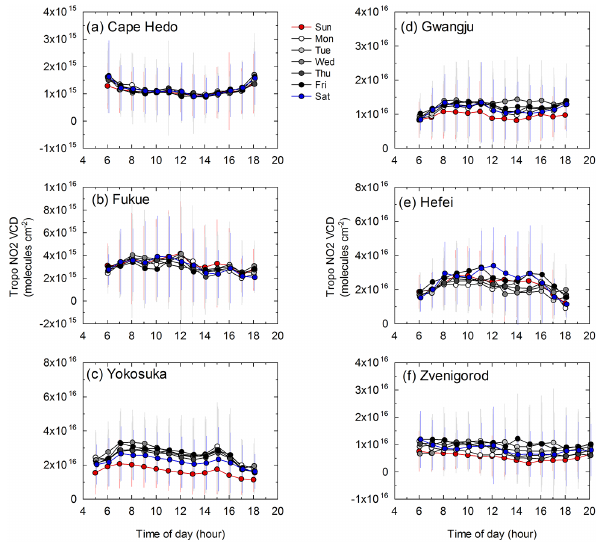
Figure 16. Weekend reduction ratios for TropoNO2VCD derived from MAX-DOAS and OMI (using the NASA ver. 2.1 algorithm). Open and closed symbols represent Saturdays and Sundays, respec-